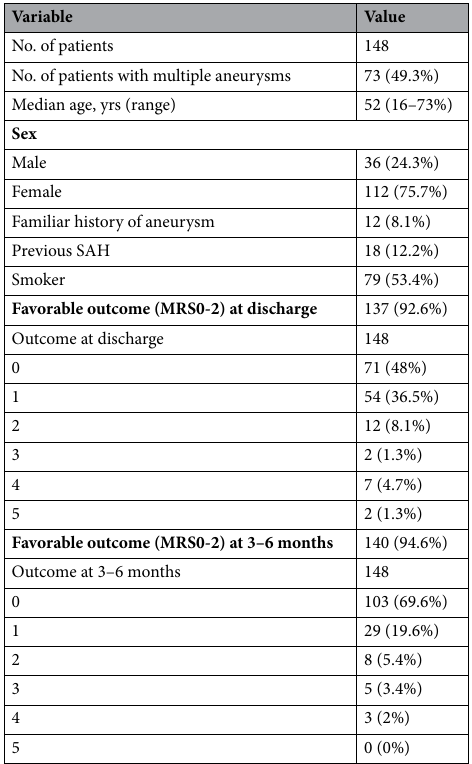
Table 2. Patient and aneurysm characteristics in unruptured wide-neck